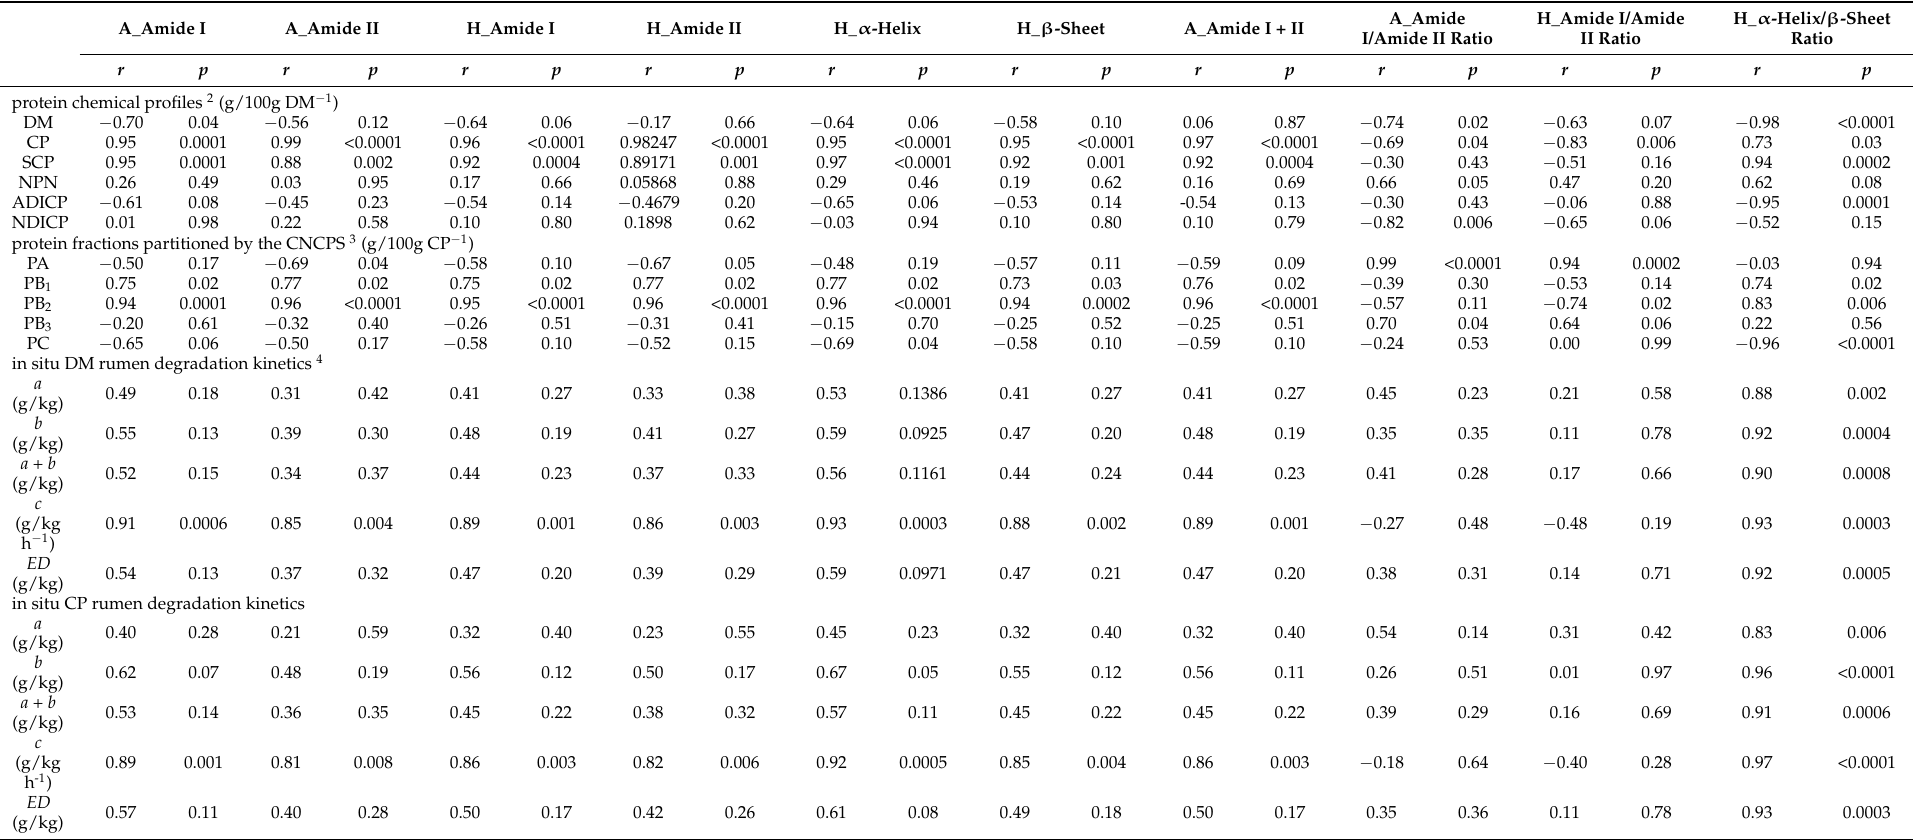
Table 4. Correlation analysis between protein molecular structural spectral parameters 1 and nutritive values in different byproducts of seed-used